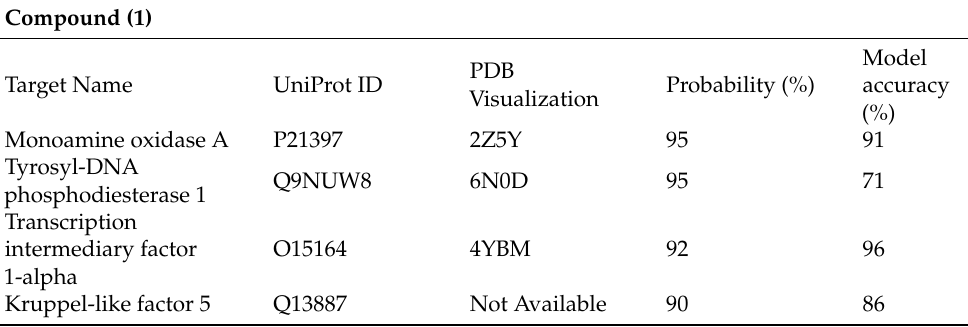
Table 7. The molecular targets of their UNIPROT and PDB code, probability of interactions, and model accuracy of